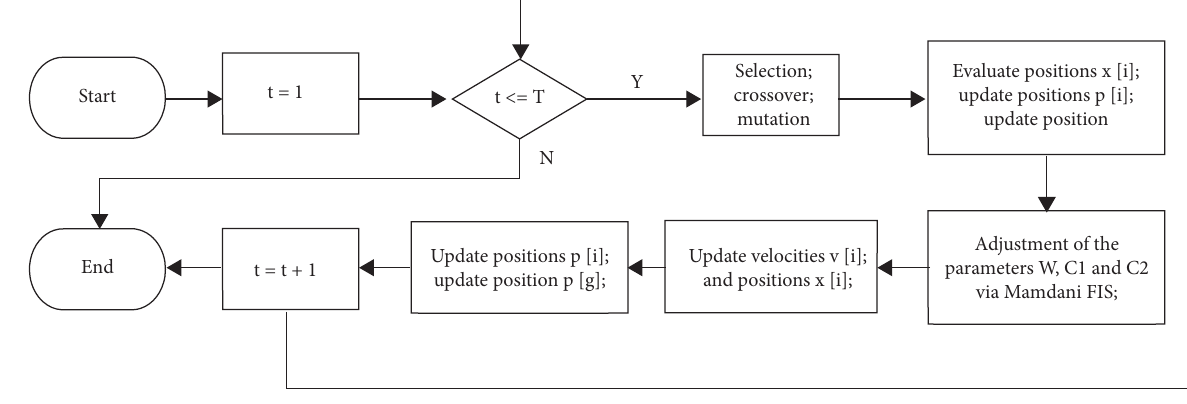
Figure 2: Adaptive GAPSO flowchart. Table 1: General optimization parameters by the GAPSO